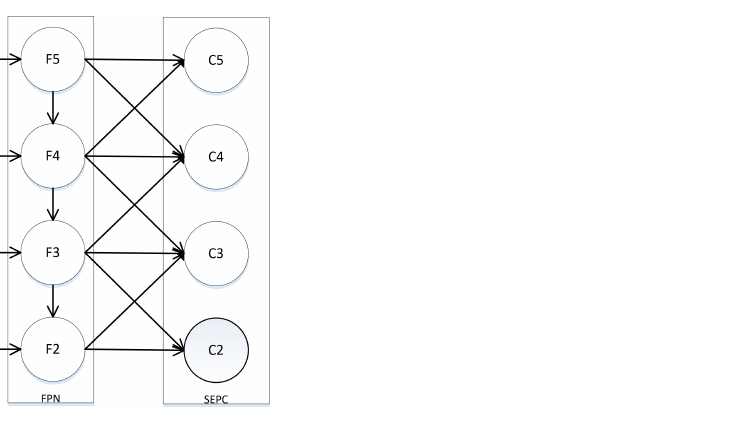
Figure 3. 3D Convolution-SEPC. Pconv apply the correlation between adjacent feature layers to fuse the features. SEPC construct a layer which use PConv on all level of input